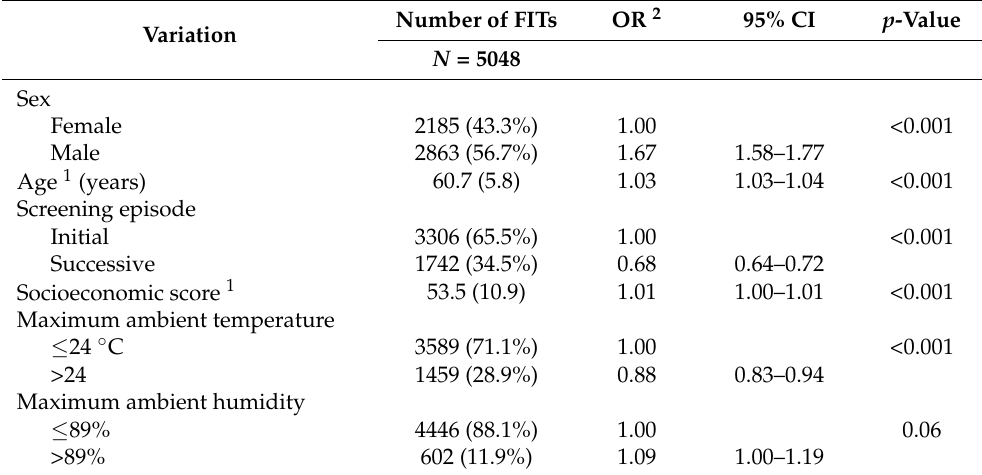
Table 3. Logistic regression of the probability of positive screening tests by temperature and humidity (95% CI).